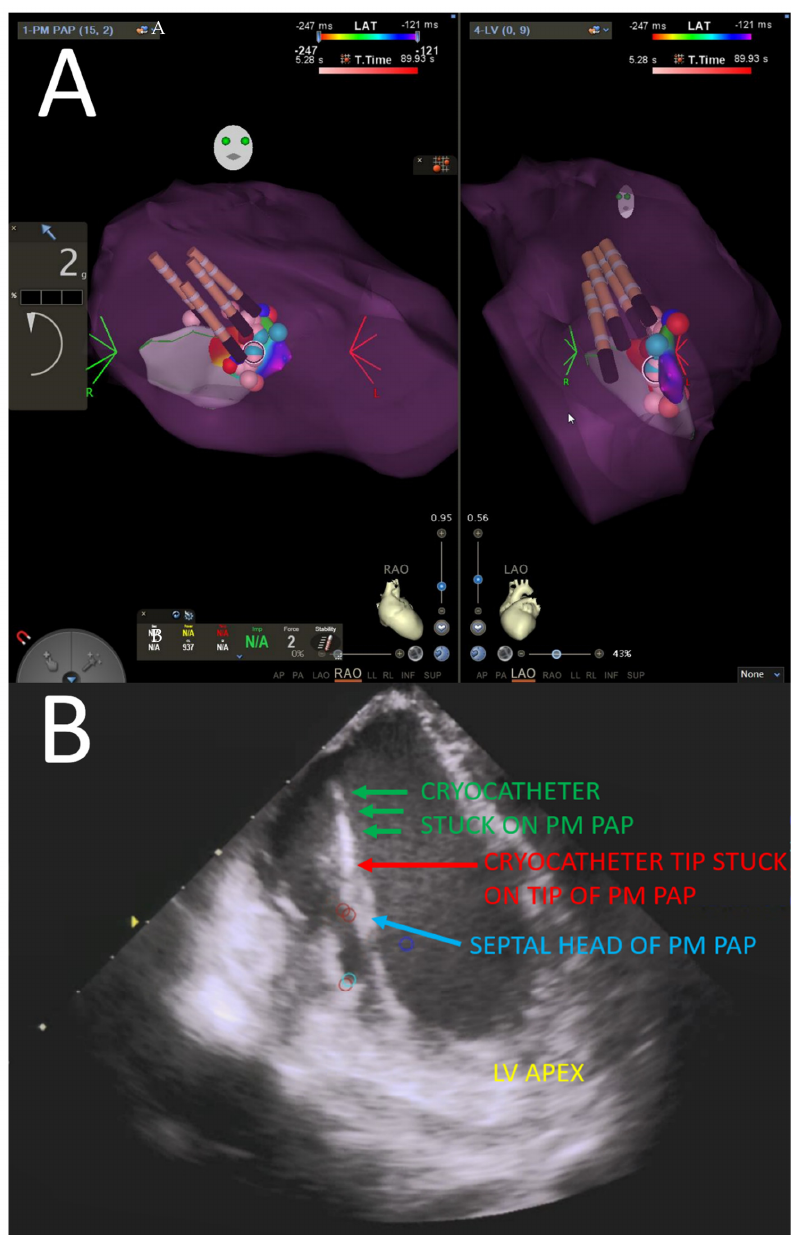
Figure 6. Papillary muscle ablation utilizing cryo-energy and intracardiac echocardiography. ( A ) Elec- troanatomic map highlighting cryo-energy lesions to a papillary muscle. ( B ) Intracardiac echocar- diography is a useful adjunct to confirm good contact and stability of catheter to papillary muscle during ablation. PM PAP: posteromedial papillary muscle, LV: left